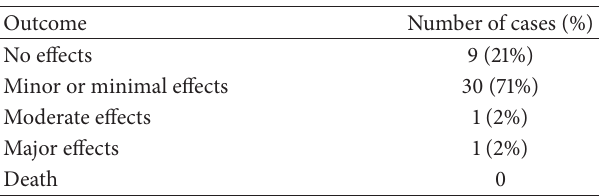
Table 3: Outcomes reported for acute methotrexate ingestions in adults as reported to six poison centers ( 𝑁 = 42 with outcomes reported out of 44